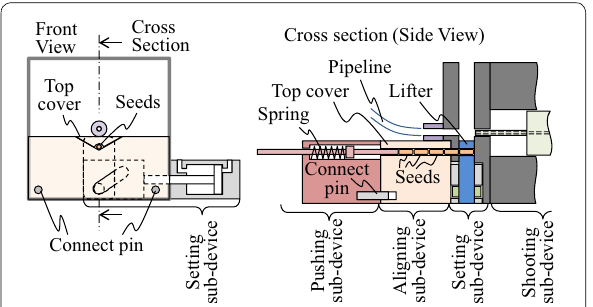
Fig. 10 Cross sections of the delivering unit front view (left) and side view (right) showing the connection of four